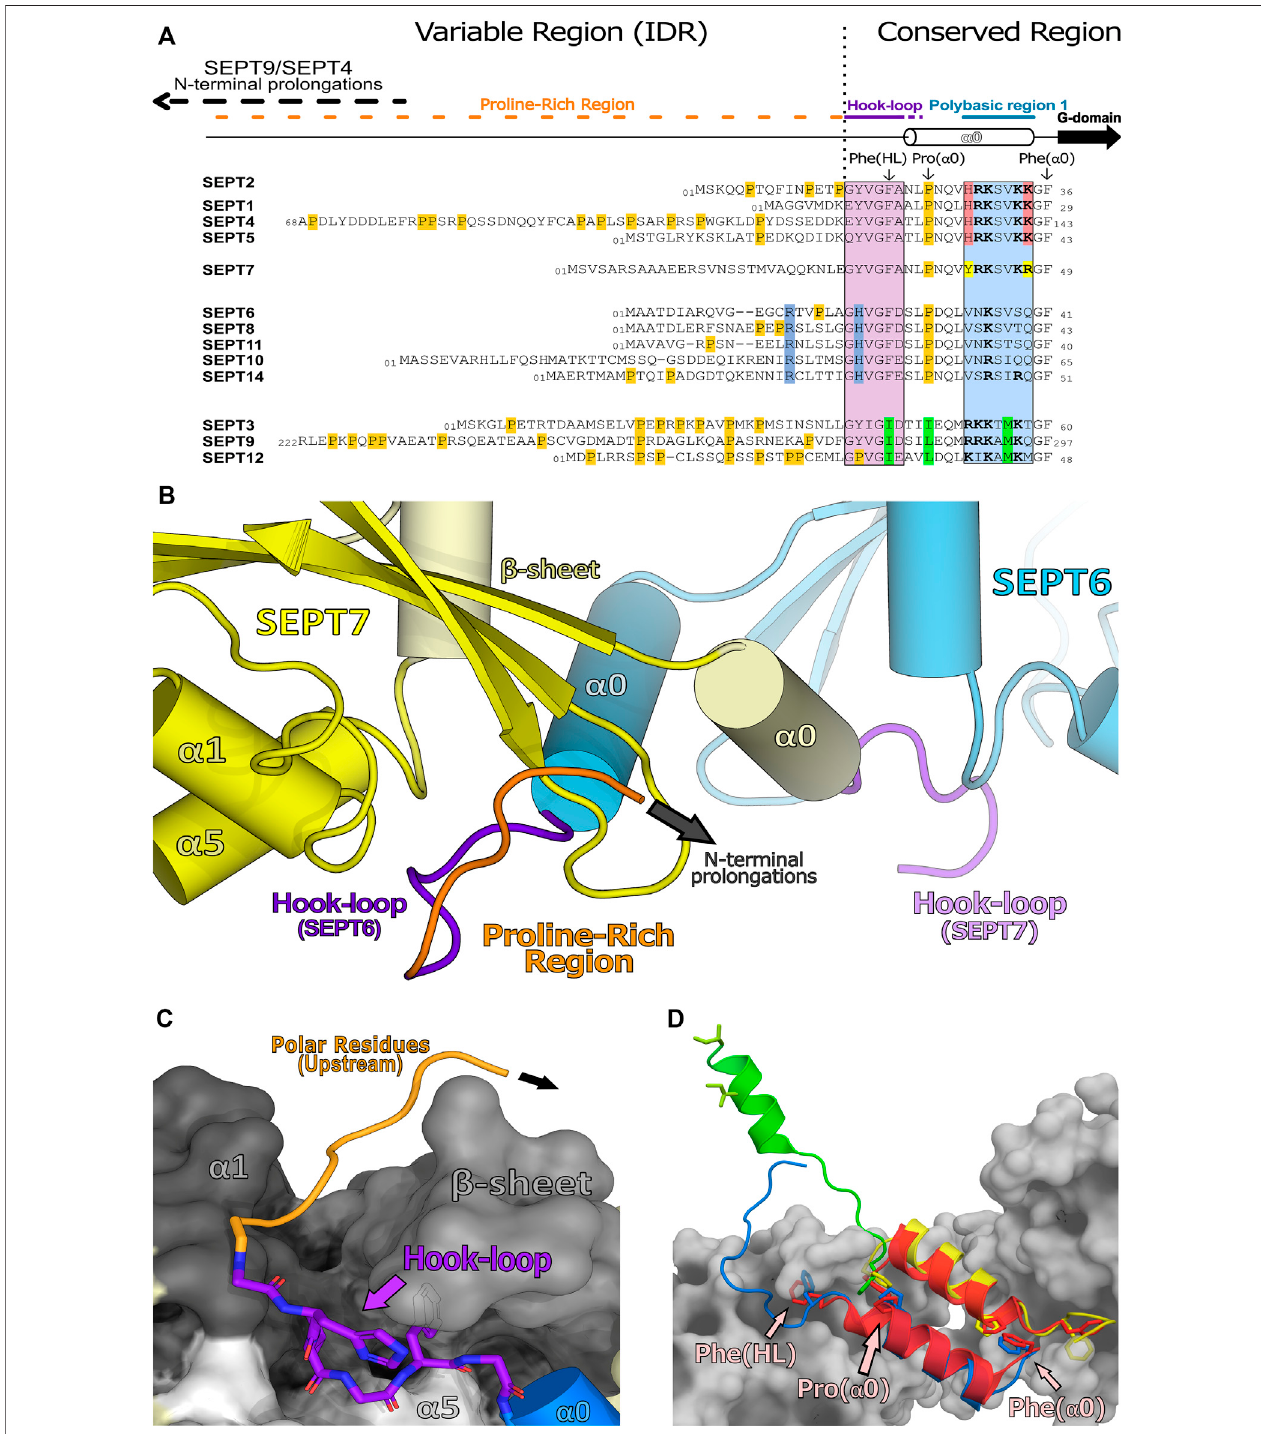
FIGURE 9 | Human septin N-domains and their structured regions. (A) Alignment of all human N-terminal sequences showing the unstructured region (variable region or intrinsically disordered region, IDR) and the structured region (conserved region). This alignment also highlights the conserved residues within a septin group (also known as characteristic residues, in their respective colors) as well as proline residues (in orange). (B) Domain-swapped “ hook-loop ” highlighting the unstructured proline region (orange) and the hook-loop (purple) (PDB:7M6J). (C) Elements of SEPT7 (in greyscale) which accommodate the hook-loop of SEPT6 into a cleft. Residues with small side chains from the “ hook-loop ” are important for these interactions. (D) Helix α 0 and its orientations within available septin structures (SEPT3 in green, PDB:4Z54; SEPT6 in blue-SEPT7 in yellow, PDB:7M6J; SEPT2 in red, PDB:2QA5). Also highlighted, as sticks, are residues which are essential for the NC- interface and/or the conformation of α 0 (Phe(HL), Phe( α 0) and Pro( α 0); indicated in only one chain for clarity). These phenylalanines act as anchors and are conserved in SEPT2, SEPT6 and SEPT7 groups but are mutated to isoleucines in the SEPT3 group which may be related to additional α 0 mobility in the latter.